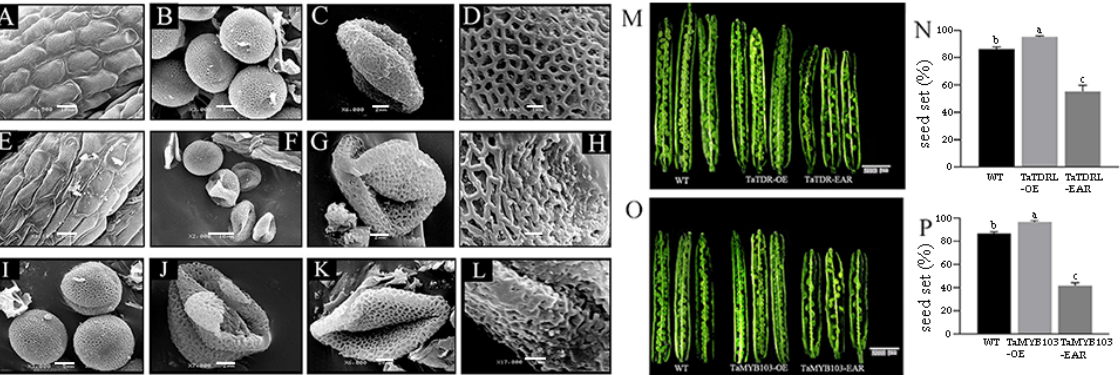
Figure 6. Scanning electric microscopic (SEM) evaluation of the microspores and analysis of the fruit pods of transgenic Arabidopsis . ( A – D ) Microspores of wild-type (WT) Arabidopsis . ( E – H ) Microspores of the TaTDRL-EAR line. ( I – L ) Microspore of the TaMYB103-EAR line. ( A , E ) Outer anther epidermis. ( B , F , I ) Microspores in the binucleate stage. ( C , G , J , K ) Microspores in the trinucleate stage. ( D , H , L ) Microspore network structure. ( M ) Fruit pods of the WT, TaTDRL-OE, and TaTDRL-EAR lines. ( O ) Fruit pods of the WT, TaMYB103-OE, and TaMYB103-EAR lines. ( N ) The seed setting rate of the WT, TaTDRL-OE, and TaTDRL-EAR lines. ( P ) The seed setting rate of the WT, TaMYB103-OE, and TaMYB103-EAR lines. Scale bars: 10 µ m in ( A , E , F ), 5 µ m in ( B , I ), 2 µ m in ( C , G , J , K ), 1 µ m in ( D , H , L ), 2000 µ m in ( M , O ). Data represent the means ± standard deviation of three biological replicates. Different lower-case letters indicated significant differences at p < 0.05.